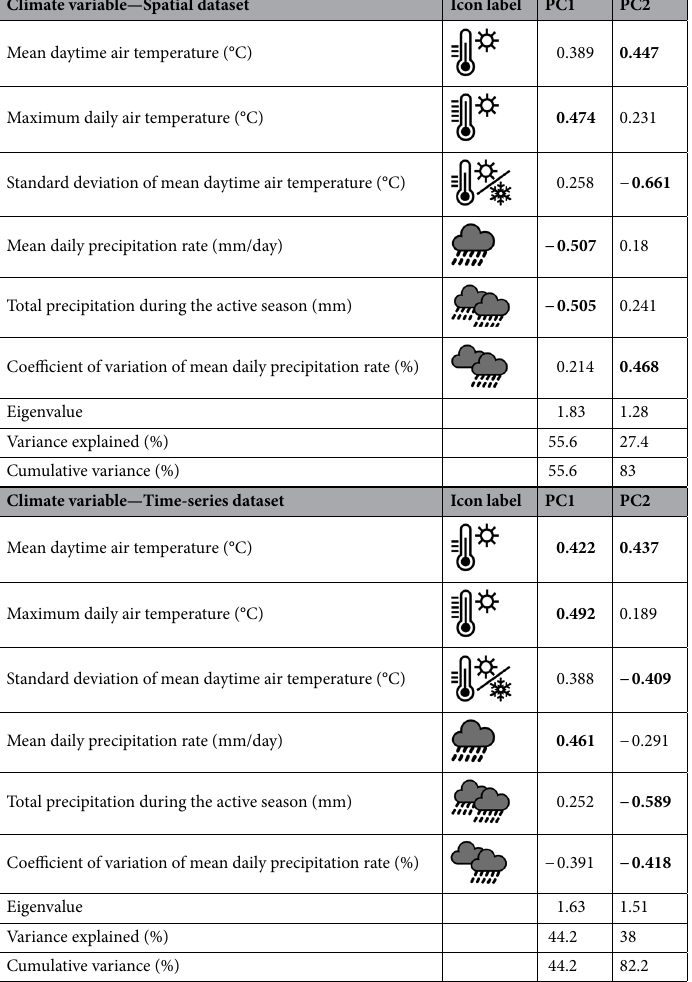
Table 1. Loadings of climate variables on the first two component axes of separate principal components analyses (PCAs) applied to the spatial and time-series datasets, respectively. Significant values are in [bold]. Each PCA was performed on the correlation matrix of raw climate data (see "Methods" for variable details). Strong loadings ( >|0.402| for the Spatial dataset and >|0.404| for the Time-series dataset) are presented in bold